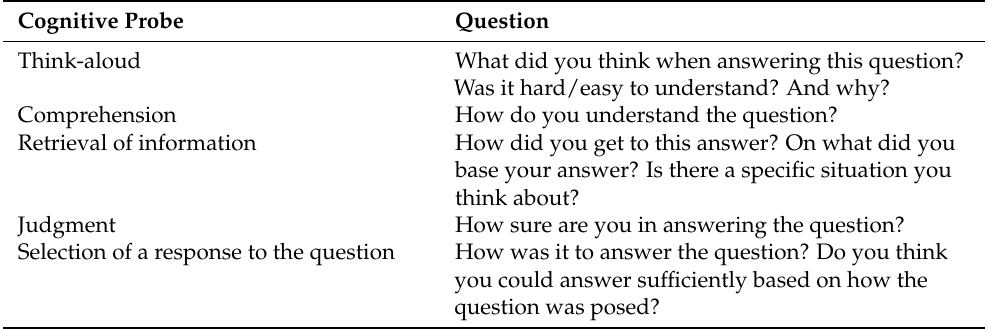
Table 1. Cognitive probe questions in the interview guide